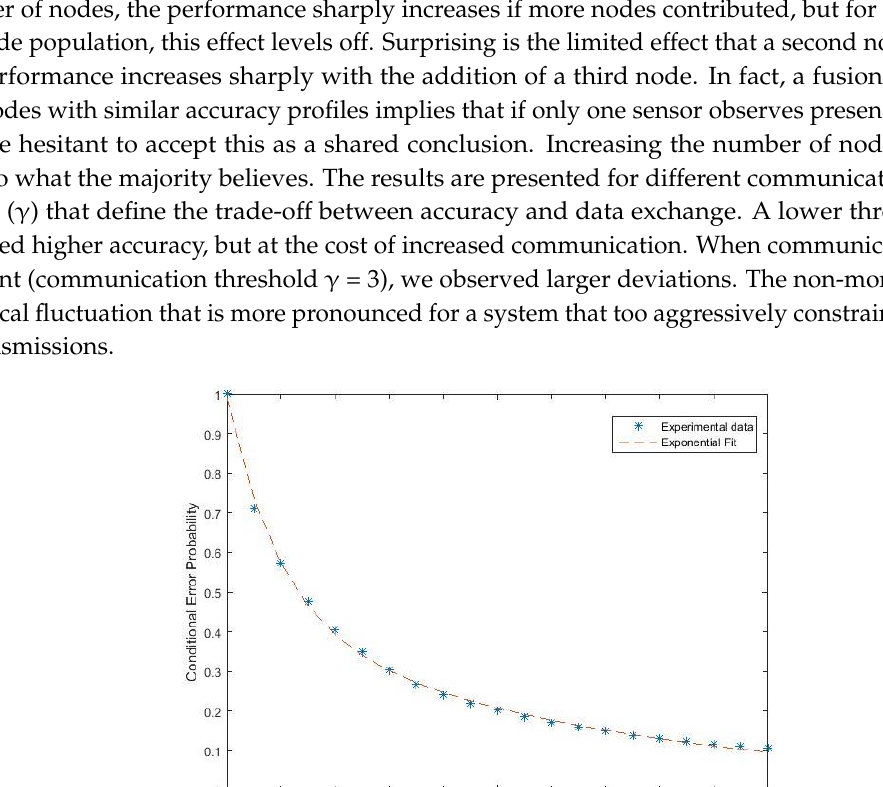
Figure 7. Measured conditional probability of an error at time 𝑡 + 𝑖 given an error in the previous time t .